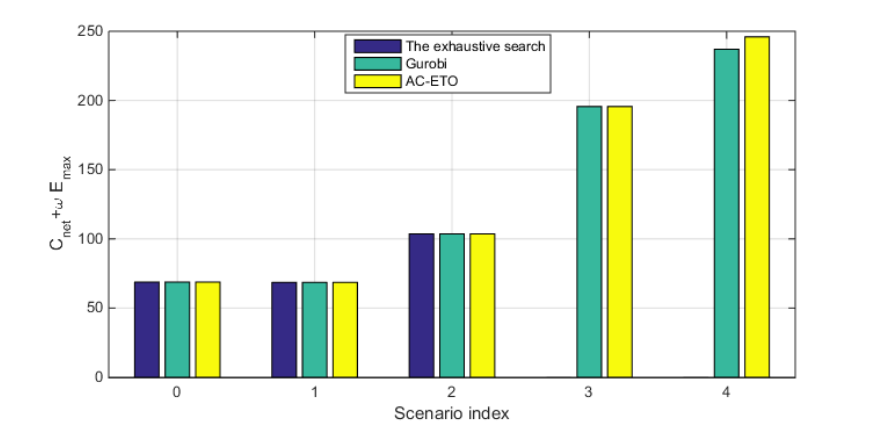
Figure 6. Comparison of the exhaustive search, Gurobi and the AC-ETO in terms of the optimization